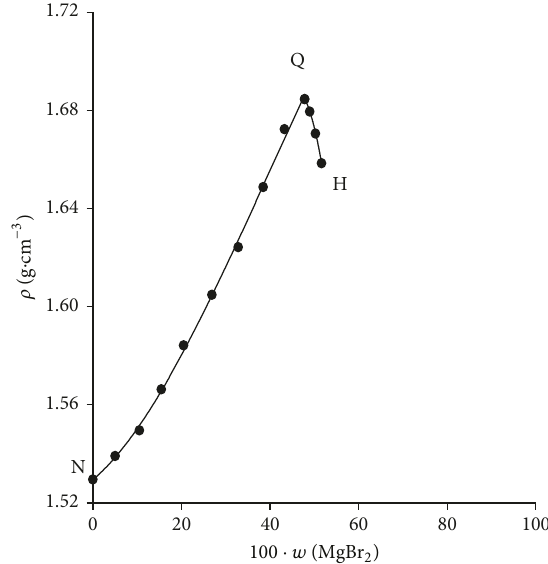
Figure 4: Density versus 100𝑤 (MgBr 2 ) in the ternary system (NaBr + MgBr 2 + H 2 O). N, Q, and H have the same meaning as described in Figure